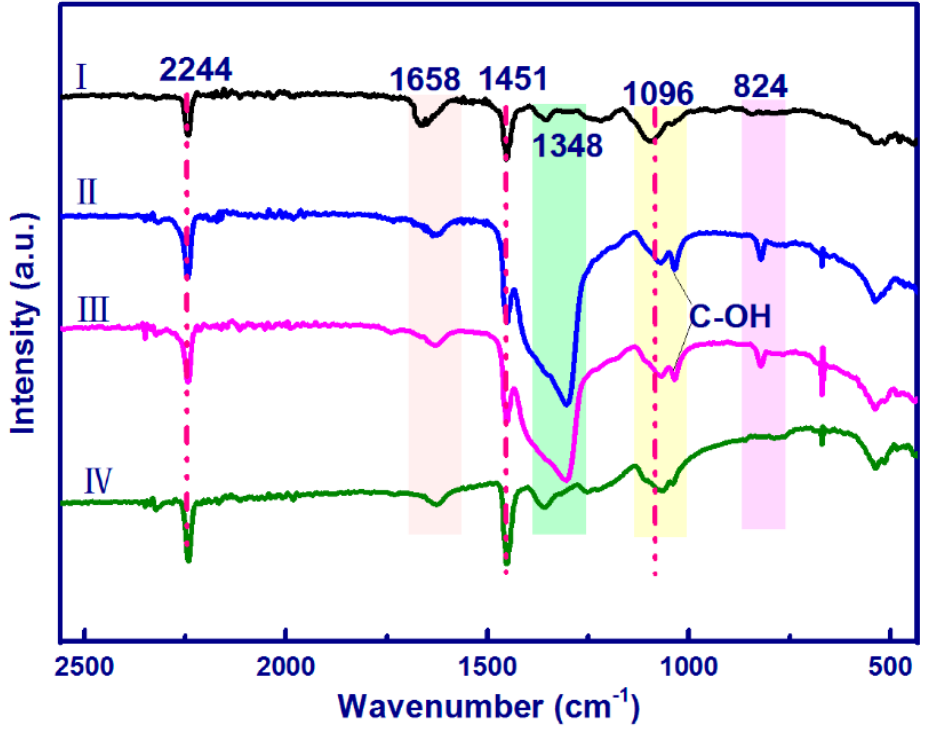
Figure 13. FTIR spectra of the electrospun nanofibers: ( I ) PAN; ( II ) PAN/CNC/Ag; ( III ) PAN/CNC/Ag/Si; and ( IV ) p-PAN/CNC/Ag/Si. Reproduced from [170] Materials (MDPI).